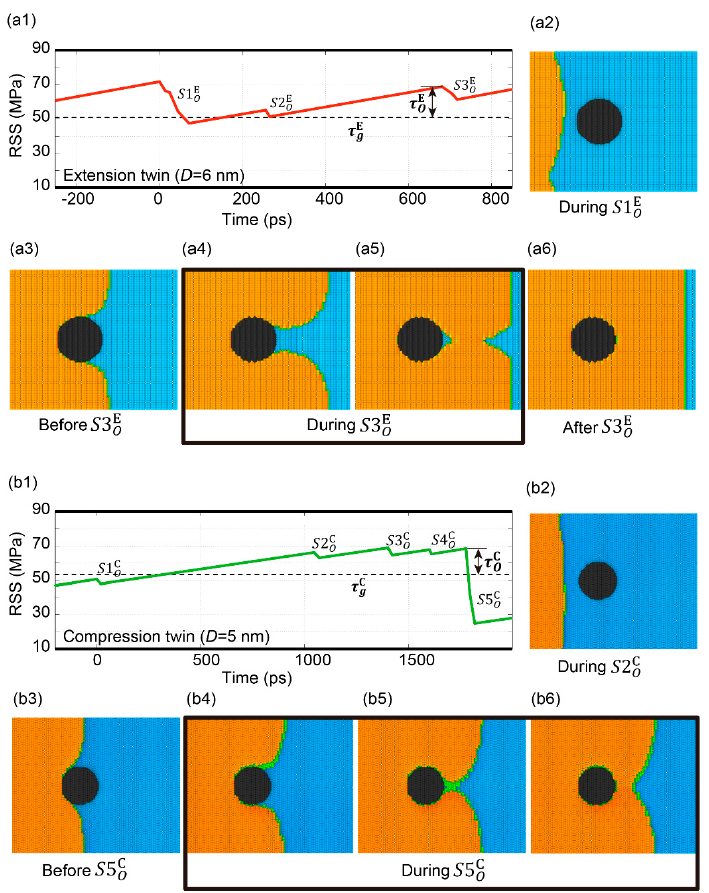
Figure 3. ( a1 , b1 ) The stick and slip events separately for extension twin and compression twin. Raw data of RSS are not shown. In the atomic-scale pictures of TD bowing and bypassing captured in MD simulation for extension twin ( a2 – a6 ) and compression twin ( b2 – b6 ), atoms are colored by their coordinates along the y-direction: orange for migrated CTB, blue for original CTB, and green for partially migrated CTB. Black ones compose the